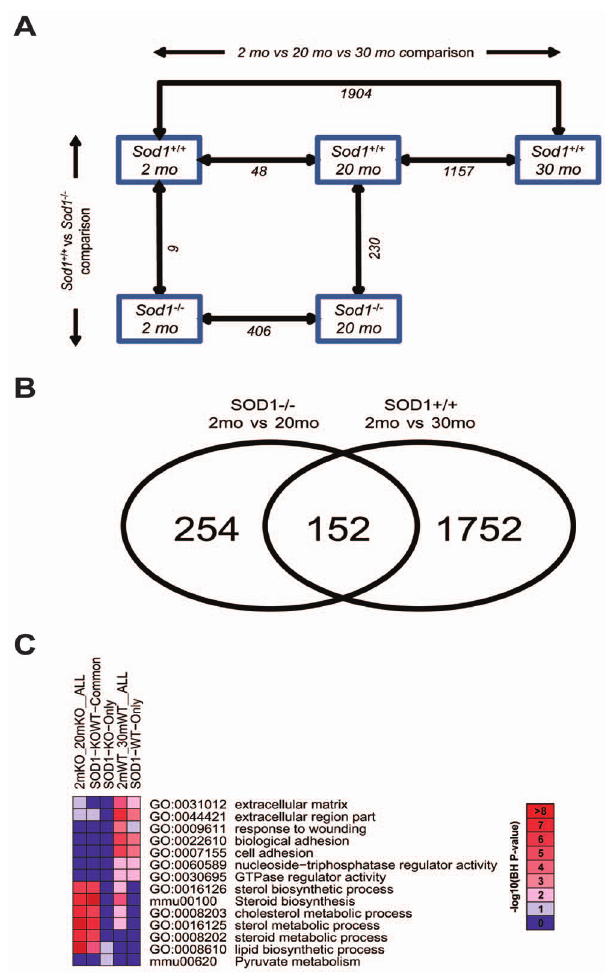
Figure 4. Assessment of gene expression in the sciatic nerve during aging. Alterations in the gene expression in the sciatic nerve during normal aging ( Sod1 + / + mice at 2 mo and 30 mo) and during increased oxidative stress ( Sod1 2 / 2 mice at 2 mo and 20 mo), were assessed using Affymetrix microarray technology. A) A comparison of the data sets for differential gene expression and the number of DEGs obtained in each comparison. IBMT FDR 5% was used to determine DEGs in age (horizontal) and genotype (vertical) group comparisons. The numbers of identified DEGs at each comparison are noted under the arrows. B) A Venn-diagram of the 2 mo/30 mo Sod1 + / + mouse comparison (normal aging) and the 2 mo/20 mo Sod1 2 / 2 mouse comparison (increased oxidative stress). C) The five DEG sets, including the two original DEG sets (denoted as 2mKO_20mKO__ALL (406 DEGs) and 2mWT_30mWT__ALL (1,904 DEGs)) and three subsets (common DEGs (denoted as SOD1-KOWT-Common (152 DEGs))) or unique DEGs to either set (SOD1-KO-Only (254 DEGs) or SOD1-WT-Only (1,752 DEGs)) from Figure 3B, were subject to functional enrichment analysis using DAVID. Benjamini-Horchberg (BH)-corrected P-values of the top 10 most significant functional terms are represented in a heat-map with – log 10 (BH-corrected P-value) as color index and number.